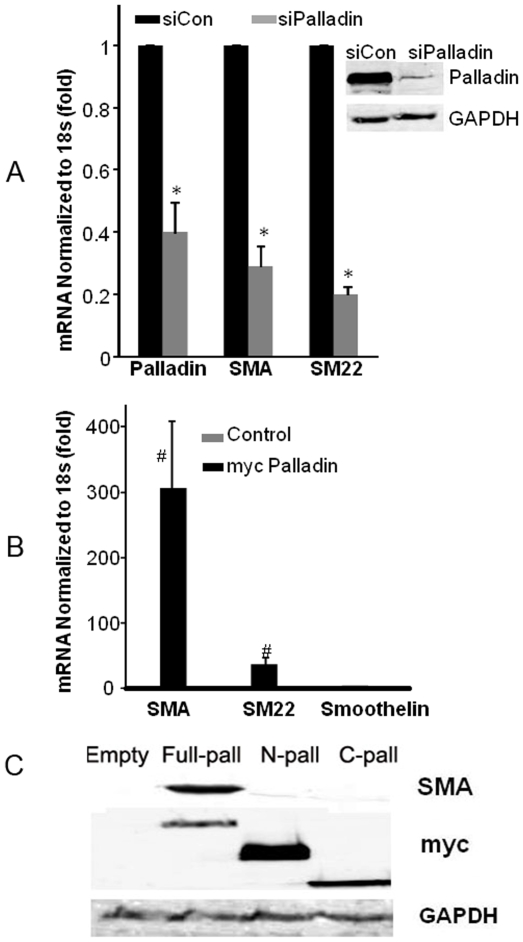
SMA and SM22 genes are down or up regulated by silencing or overexpression of palladin.A) Undifferentiated A404 cells were transfected with siRNA oligos and then treated with RA for 48 h. The expression of SMA, SM22, and palladin was determined by real time RT-PCR, and normalized to ribosomal 18s. Values represent the mean±SEM, n = 3. * p<0.05. Inset shows overexpressed palladin was knocked down with siRNA. B) Undifferentiated A404 cells were transfected with myc tagged palladin constructs, and cells were harvested 36 h after transfection. The mRNA expression of SMC marker genes was measured by real time RT-PCR using specific primers, and normalized to ribosomal18s. Values represent the mean±SEM (n = 3). #,p<0.01. C) Representative Western blots show that overexpression of full length, but not the amino (N) or carboxyl (C) terminal halves of palladin can induce SMA expression. Smoothelin expression was not changed. Undifferentiated A404 cells were transfected with myc tagged palladin constructs, and harvested 36 h after transfection. The cell lysates were loaded for SDS-PAGE, and blotted with anti-SMA, palladin, and GAPDH antibodies. The protein expression was normalized to GAPDH.